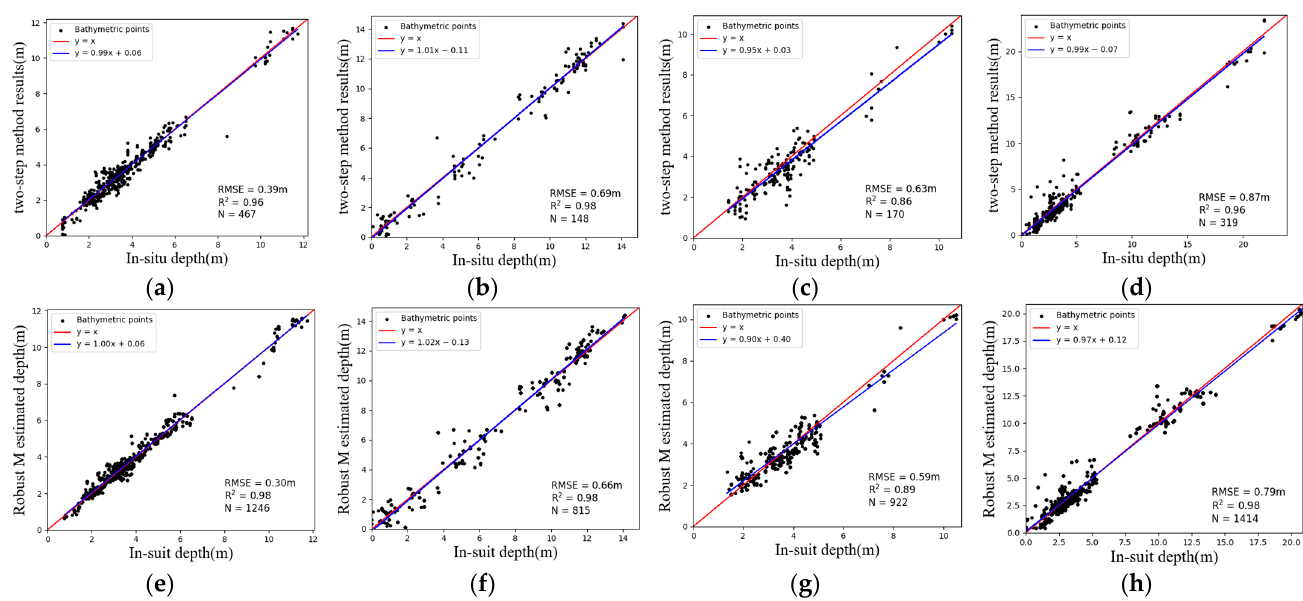
Figure 13. Error sca tt er diagrams of the two methods in di ff erent environments. ( a ) Two-step method for 480 orbit gt1r beam, ( b ) 480 orbit gt2r beam, ( c ) 1036 orbit gt2r beam, and ( d ) 1036 orbit gt1r beam; ( e ) M-estimation for 480 orbit gt1r beam, ( f ) 480 orbit gt2r beam, ( g ) 1036 orbit gt2r beam, and ( h ) 1036 orbit gt1r beam.